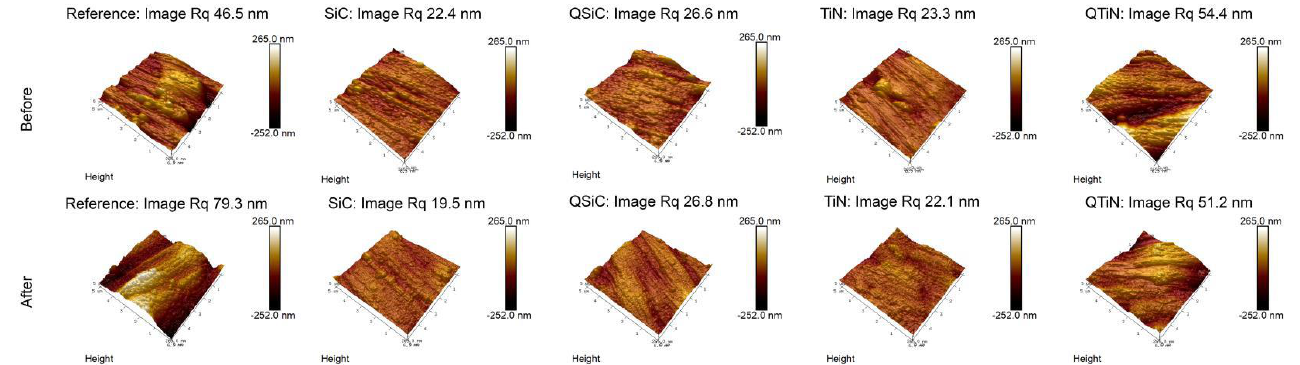
Figure 4. Roughness means values and standard deviation in non-coated (Reference) and coated (TiN, QTiN, SiC, and QSiC) disks before and after 30 days in cultivation with bacteria. AFM images of surface topography of Ti disks non-coated and coated, with amplifications of 10 µm.